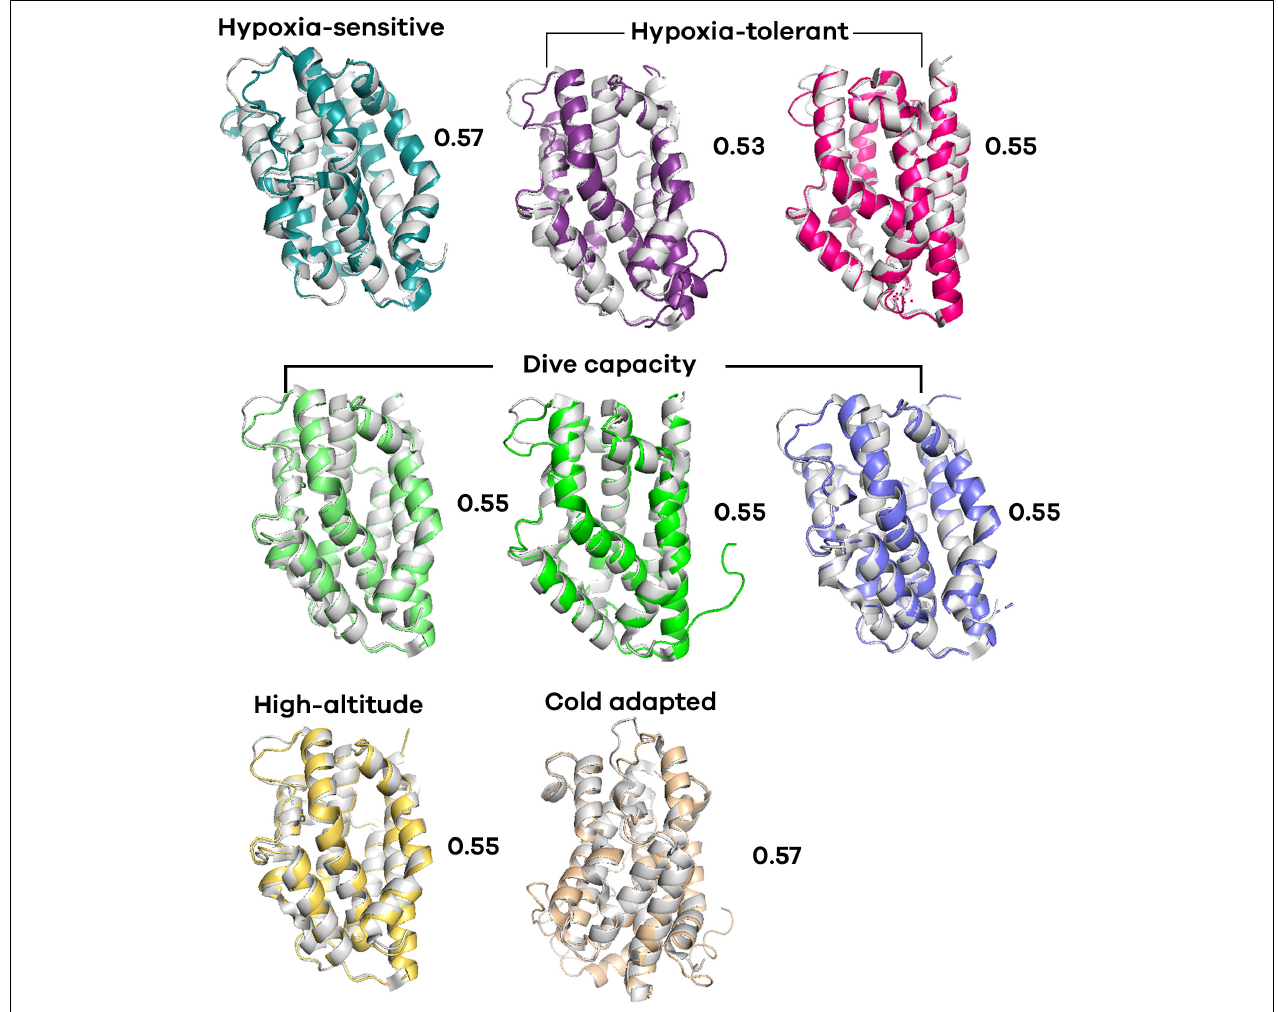
FIGURE 3 | Predicted tertiary structure alignment of heme oxygenase 1 (HO-1) of vertebrates with different physiology adaptations. All structures were aligned with the human HO-1. Rat ( Rattus rattus ) (cyan), mummichog ( Fundulus heteroclitus ) (purple), naked-mole rat ( Heterocephalus glaber ) (magenta), sperm whale ( Physeter catodon ) (opaque green), bottlenose dolphin ( Tursiops truncatus ) (green), California sea lion ( Zalophus californianus ) (blue), deer mouse ( Peromyscus maniculatus bairdii ) (yellow), common frog ( Rana temporaria ) (wheat). The root mean square deviation (RMSD) values are